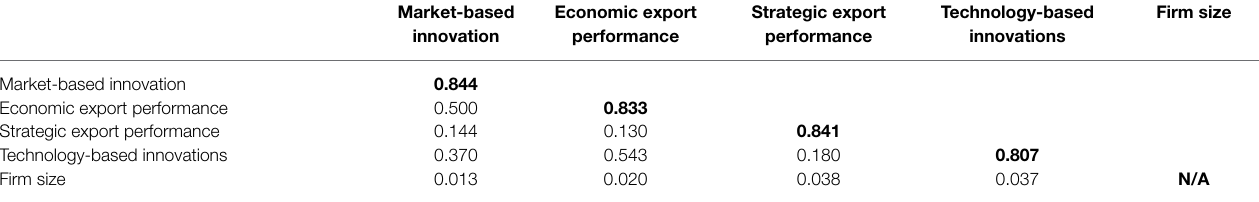
TABLE 4 | Discriminant validity.